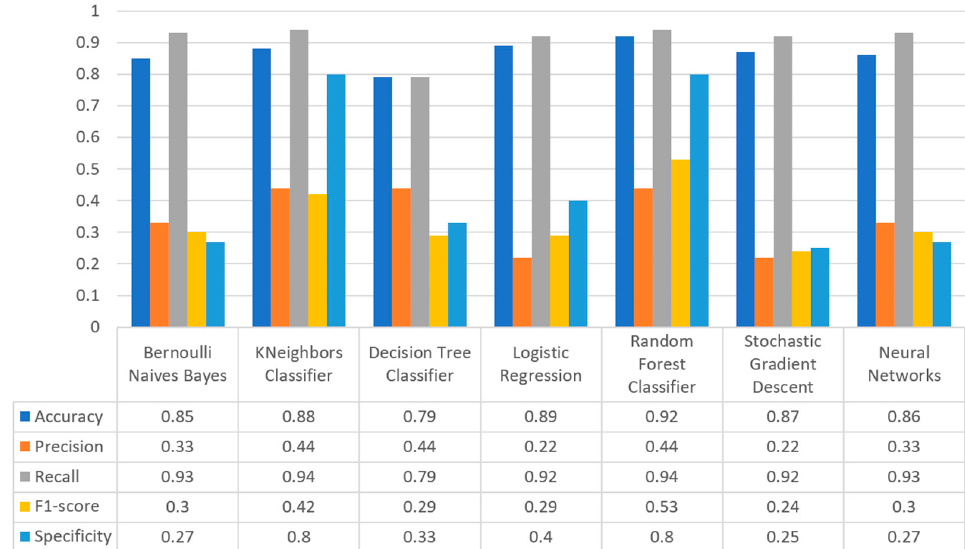
Figure 29. Performance comparison in the breast cancer use case.